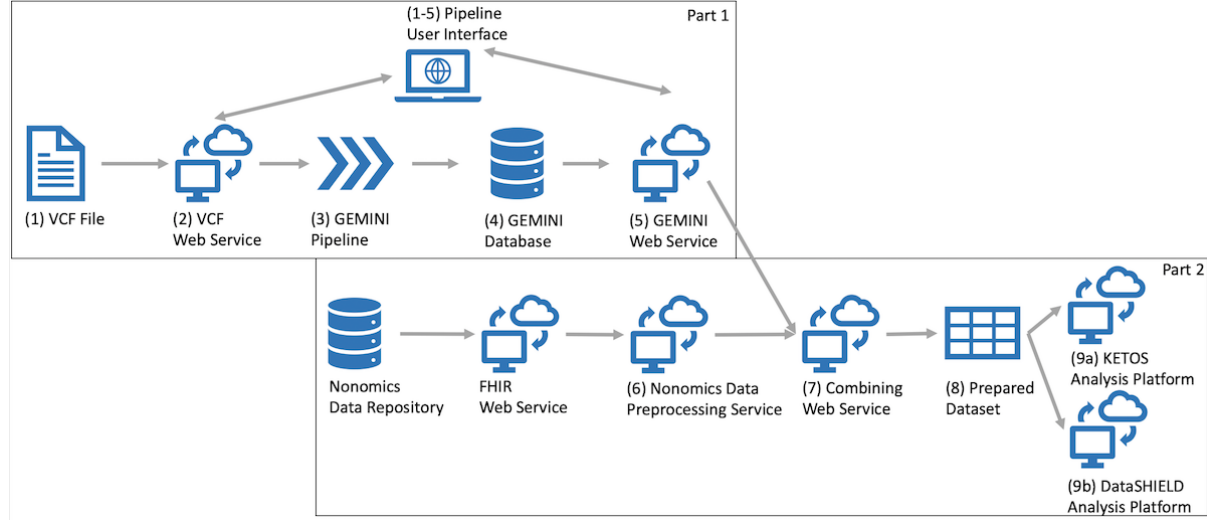
Figure 5. Combining genomics and patient data. VCF: variant call format; GEMINI: GEnome MINIng; FHIR: Fast Healthcare Interoperability